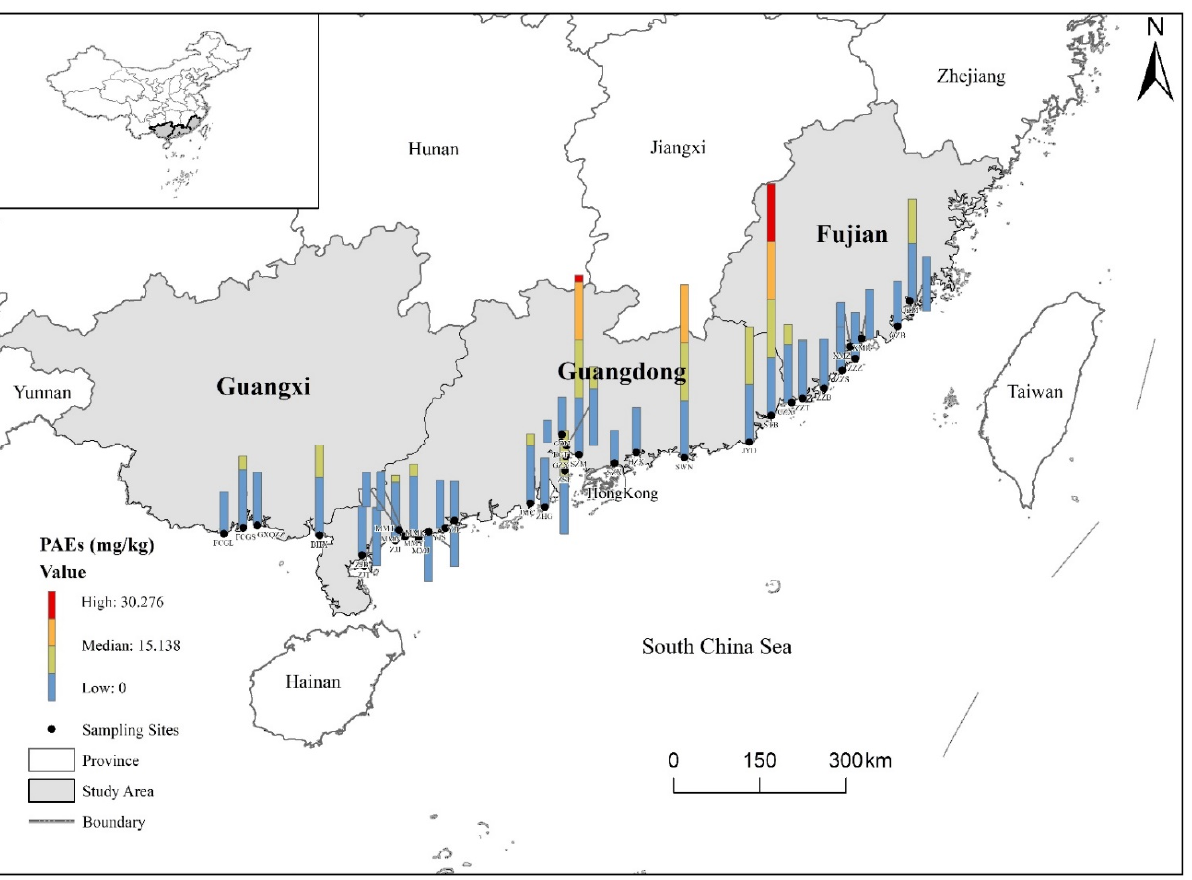
Figure 2. Concentration and geographical distribution of PAEs in plants in coastal areas of South China.